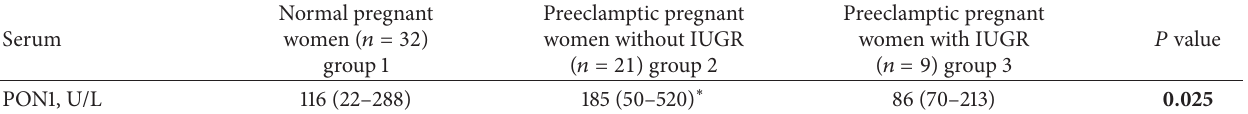
Table 6: Serum PON1 activity in preeclamptic without/with and normal pregnant women. Normal pregnant Serum PON1, U/L Median (Min–Max) Statistically significant 𝑃 < 0.05